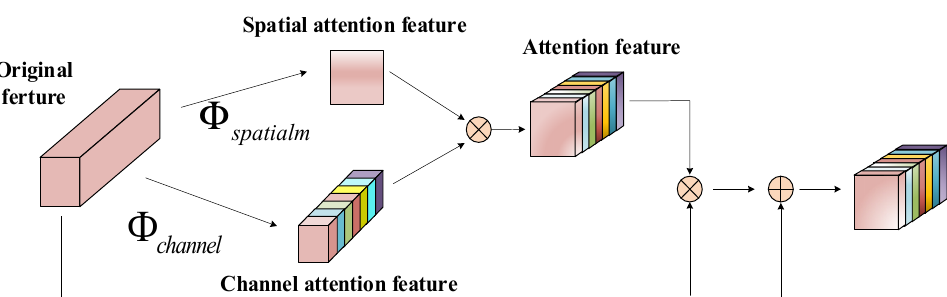
Figure 6. Structure diagram of the CBAM module. 2.6. Improved Non-Maximum Suppression Algorithm (Soft-NMS) The Faster RCNN uses the NMS algorithm to detect the target frame. The implemen- tation principle of the NMS algorithm is as follows: preselect the detection frame with the highest con fi dence in the region of interest, traverse the coincidence degree of all the other detection frames with the detection frame and remove the detection frame with a high degree of coincidence to realize the purpose of reducing duplicate detection boxes. The Intersection Over Union ratio (IoU) is a calculation method for evaluating the positioning accuracy, which de fi nes the degree of overlap between the two detection frames. The cal- culation formula of the IoU is shown in Formula (5). 𝑖𝑜𝑢 = 𝐴 ∩ 𝐵 𝐴 ∪ 𝐵